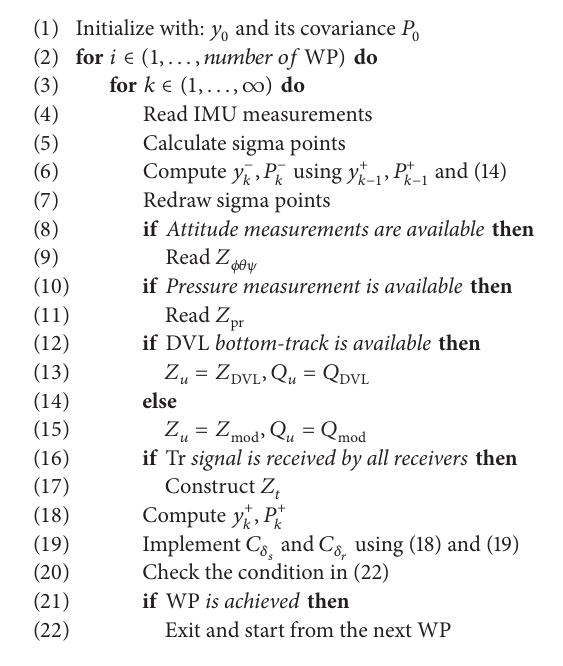
Algorithm 1: AUV localization and navigation